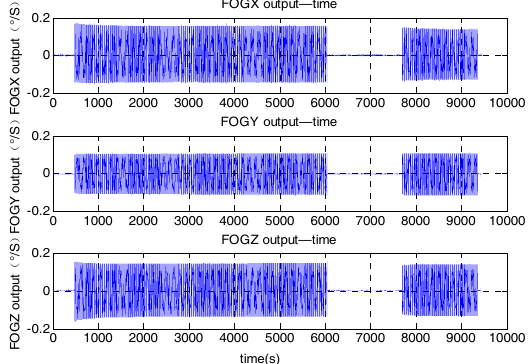
Figure 3. Raw data of the Fiber Optic Gyroscopes (FOGs) in the fixed frequency vibration.